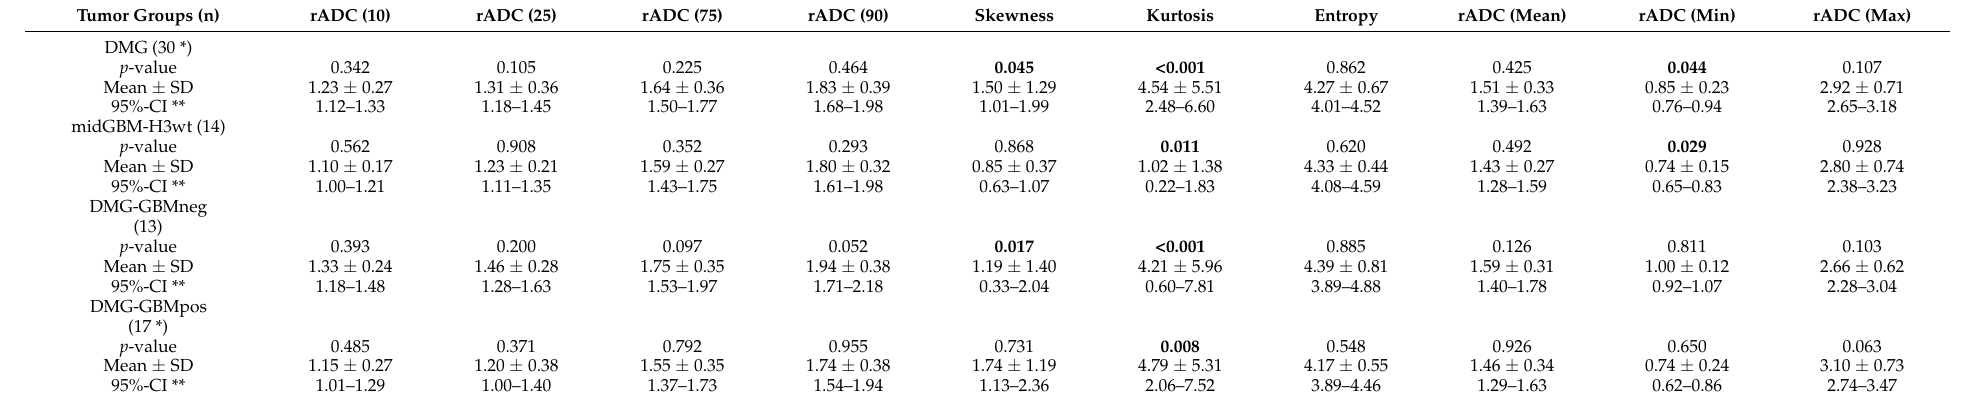
Table 3. Results of histogram as well as whole-tumor-ROI (r)ADC analysis for the different tumor groups. Normal distribution analysis using the Shapiro–Wilk test, result is indicated by the p